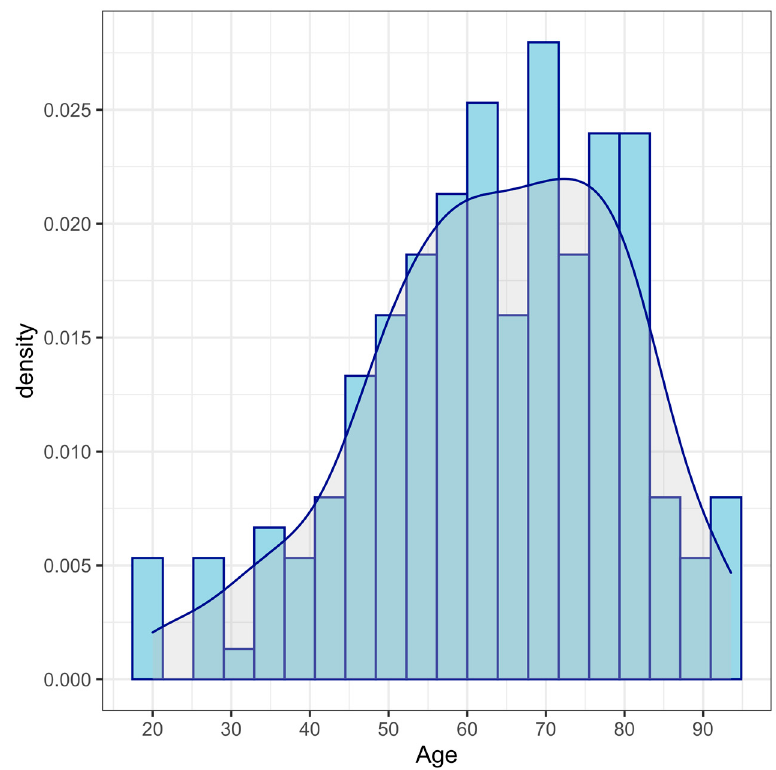
Figure 1. Frequency age distribution of the analyzed sample. Table 1. Age distribution of the analyzed sample.